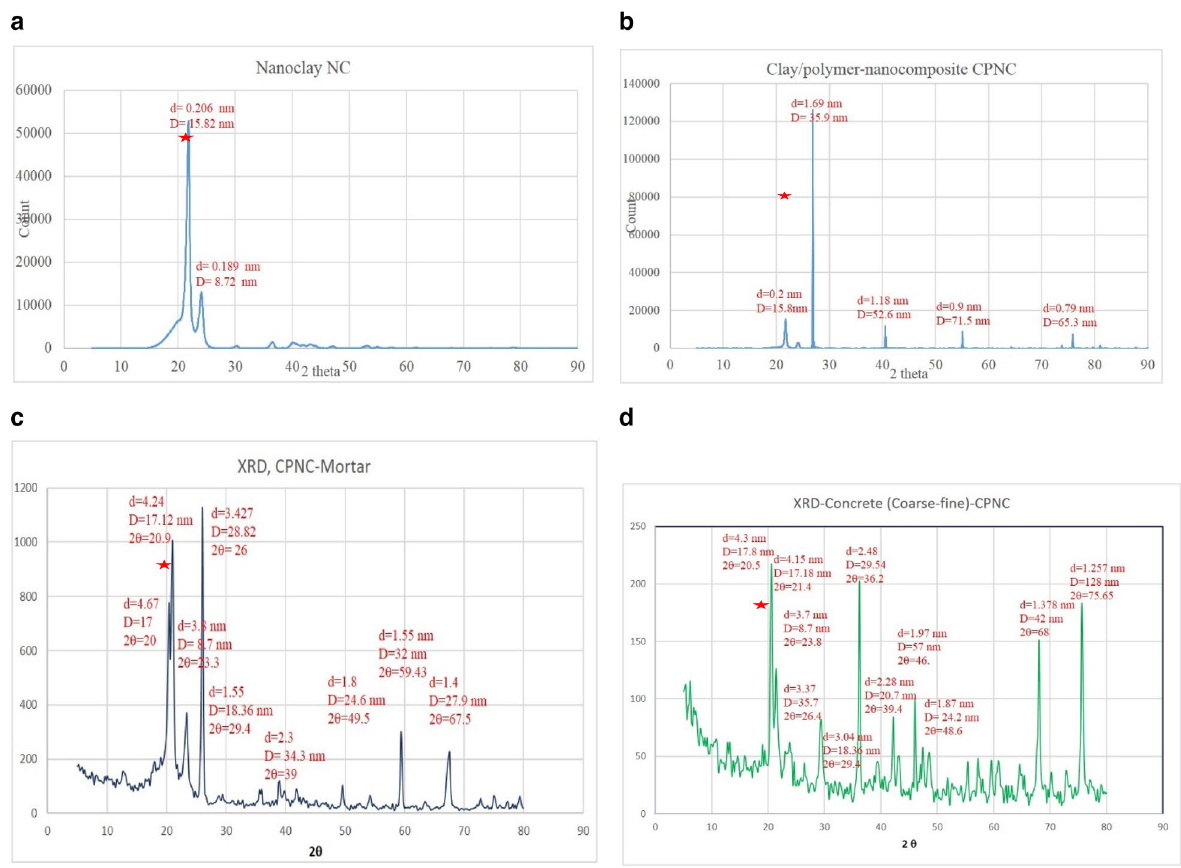
Figure 6. ( a ) XRD of MMT (I.30 T), showing original d between nanoclay layers ( ). ( b ) XRD result of CPNC (MMT mixed with melted HDPE), showing the change in d ( ) between nanoclay layers due to mixing. ( c) XRD results for CPNC mortar (melted CPNC mixed with sand), showing the change in d ( ) between nanoclay layers due to mixing. ( d) XRD results for CPNC concrete (melted CPNC with sand and coarse aggregate) showing the change in d ( ) between nanoclay layers due to